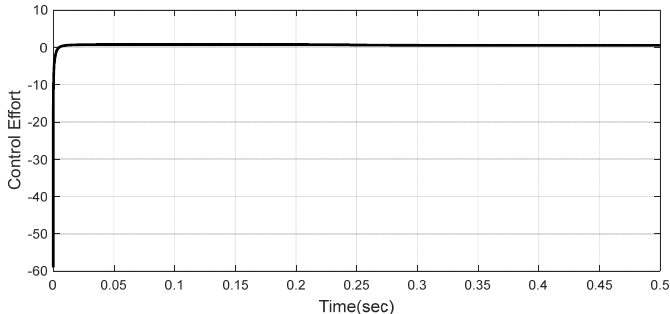
Figure 29. Control effort signal in the presence of measurement noise.